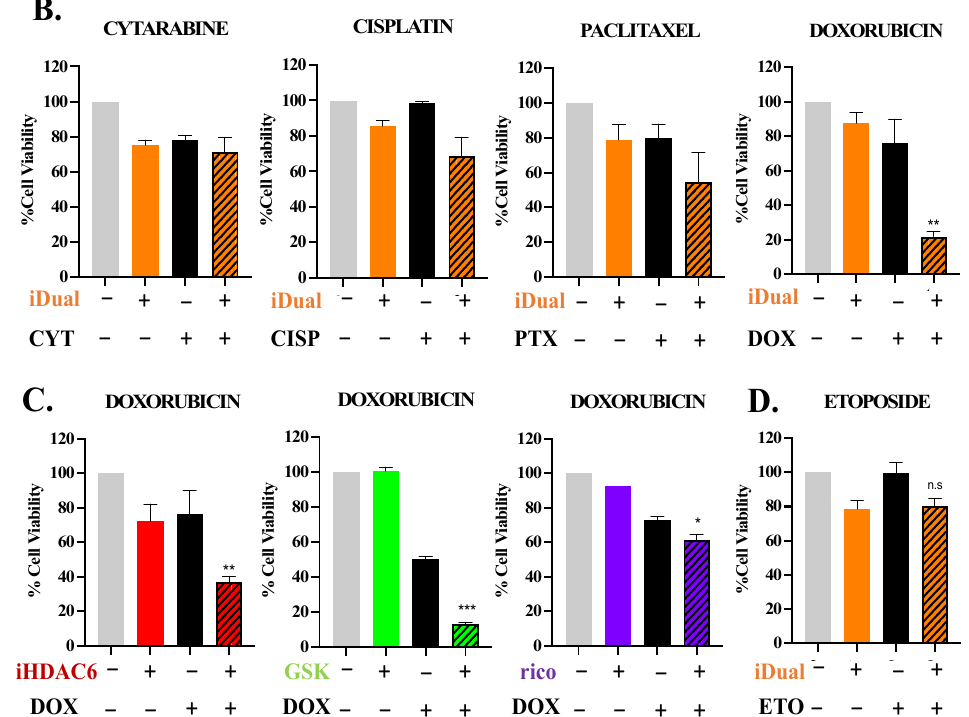
Figure 5. Cell viability in THP-1 cells after combination therapy with epigenetic inhibitors and clinically used agents. ( A ) Design of the THP-1 cell viability assays. Cells were pretreated with the epidrugs for 72 h and further incubated with the chemodrugs in combination with fresh epidrugs for an additional 48 h before viability was measured. Cell viability was measured using ATP-dependent cell-titer glo assay and normalized to control cells. The figure was generated in BioRender.com. ( B ) Pre-treatment with dual inhibitor 2 (iDual, 5 µ M, 72 h) followed by co-treatment (48 h) with iDual (5 µ M) and a sublethal concentration of the antileukemic drugs cytarabine (CYT, 0.62 µ M), cisplatin (CISP, 1.25 µ M), paclitaxel (PTX, 3 nM), or doxorubicin (DOX, 62.5 nM). ( C ) Pretreatment with iHDAC6, GSK2879552, or ricolinostat, followed by co-treatment with a sublethal concentration of doxorubicin. ( D ) Pre-treatment with dual inhibitor followed by co-treatment with a sublethal concentration of the topoisomerase II inhibitor etoposide (ETO, 0.2 µ M). Data were represented as the average of ± standard deviation from three biological repeats (* p < 0.05, ** p < 0.01, *** p < 0.001 and n.s: not significant) ordinary one-way ANOVA, Tukey’s multiple comparisons